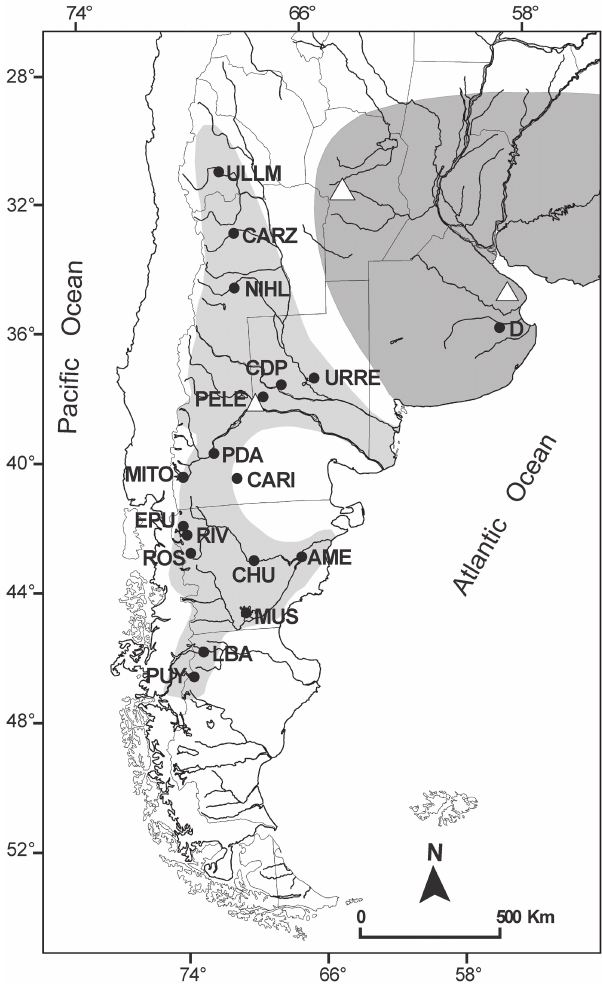
Fig. 1. Distribution of O. hatcheri (light gray) and